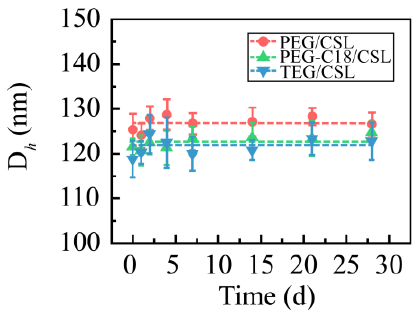
Figure 3. Particle size of three CSL nanoparticles during the entire storage process (n = 3).